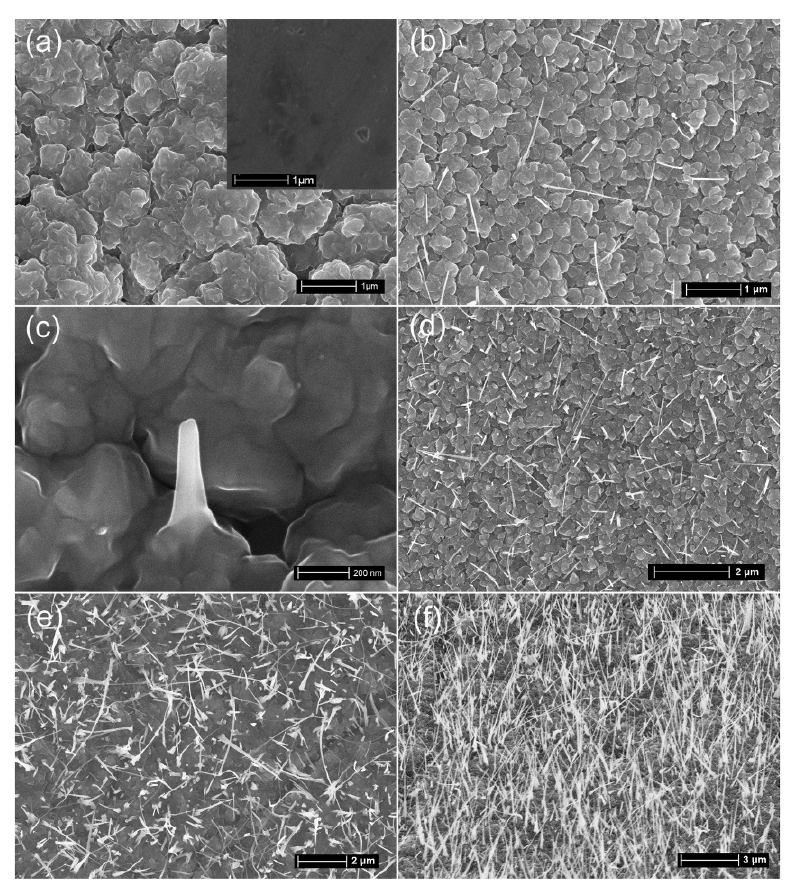
Figure 3. SEM images of the morphology of Cu foil surface heat-treated at 1 min (a), 5 min (b), 10 min (d), 30 min (e) and 60 min (f). (c) A close view of a nanowire in growth. The inset of a is the Cu foil before the heat